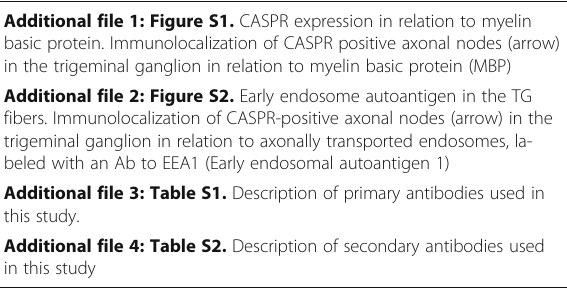
Additional file 4: Table S2. Description of secondary antibodies used in this